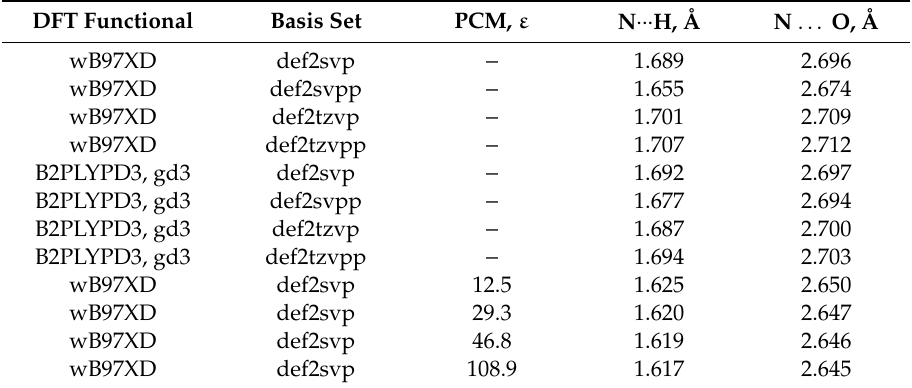
Table 2. H-bond geometry of 4 under di ff erent DFT (Density Functional Theory) approximations. DFT Functional